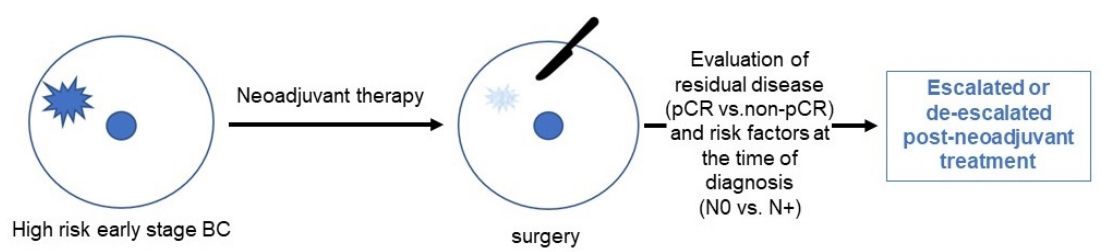
Figure 1. A flow of neoadjuvant and post-neoadjuvant treatment in breast cancer.